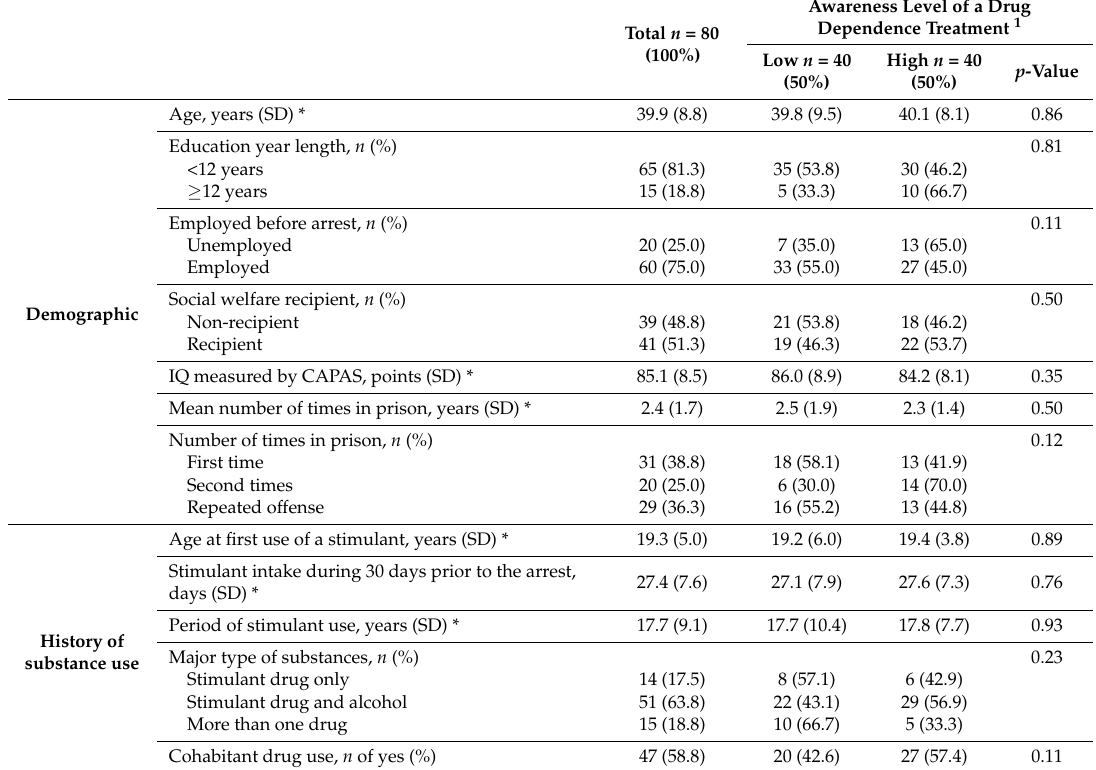
Table 1. Study participant characteristics stratified by level of drug dependence treatment